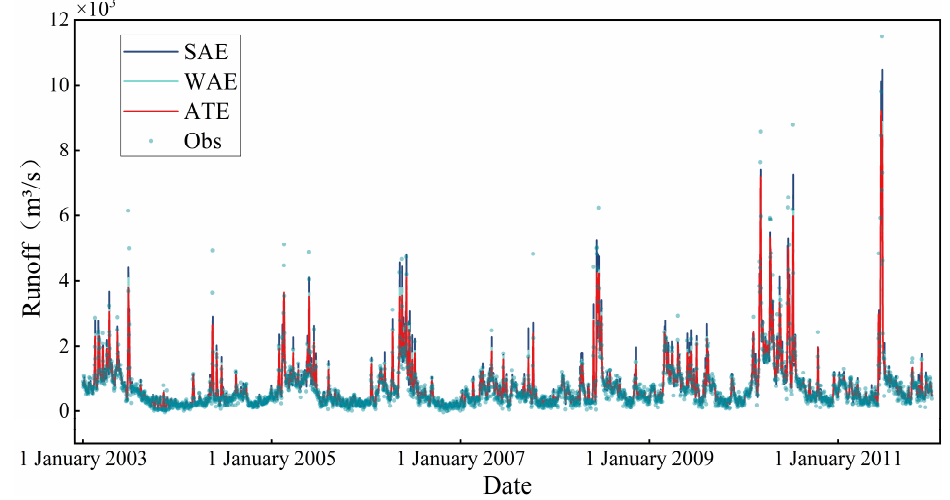
Figure 9. Prediction results of the stacking models in the testing period.